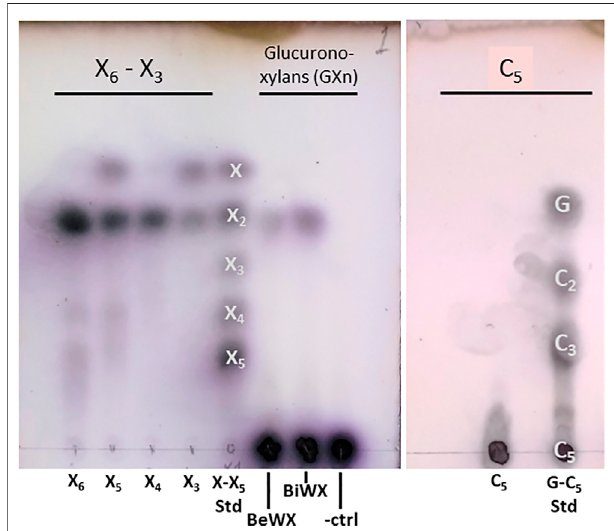
FIGURE 1 | TLC showing Ac Xbh30A-CD hydrolysis of XOS, two common GX n types, and cellopentaose. The results indicate that only a small amount of X 2 is liberated from polymeric GX n , while hydrolysis of even- numbered XOSs yielded only X 2 and hydrolysis of odd-numbered XOSs yieldedX 2 andxylose.Importantly,usingthesameTLCmethod,noanalogous activity could be detected for the Ac Xbh30A-CD hydrolysis of cellopentaose (C 5 ), indicating that the C6 position is not accommodated in the -1 and/or -2 subsites that establish the X 2 binding pocket. Samples and standards for the xylan-based assay include xylose (X) through xylopentaose (X 5 ) with beechwood glucuronoxylan (BeWX) and birchwood glucuronoxylan (BiWX) reactions as well as a BeWX no enzyme control (-ctrl). For C 5 hydrolysis, analysis included glucose (G), cellobiose (C 2 ), cellotriose (C 3 ) and cellopentaose (C 5 ) as